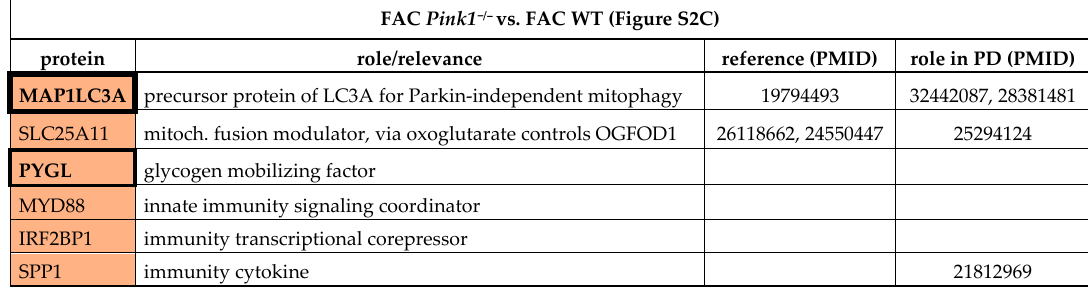
Table 3. PINK1 effects. Overview of selected significantly changed factors in the global proteome of MEF, comparing FAC Pink1 − / − vs. FAC WT, 22BP Pink1 − / − vs. 22BP WT, and control Pink1 − / − vs. control WT, listing their respective roles and PMIDs, and highlighting special relevance for PD. Upregulations are shown with dark red (FDR > 0.05) and light red ( p > 0.05), whereas downregulations are marked with dark green (FDR > 0.05) and light green ( p > 0.05). Factors that show converse regulations after iron overload versus iron depletion and thus appear in several tables are marked with bold fonts. Factors with dysregulations in diverse conditions are emphasized by increased table cell border thickness. For details, see Figure 2 and Supplementary Table S1.